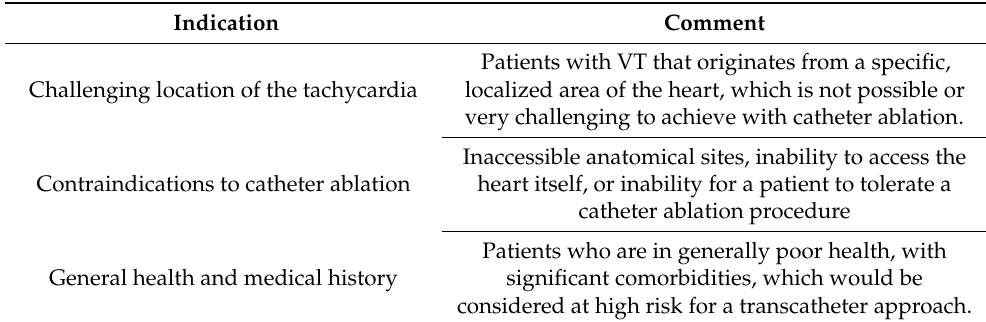
Table 1. General patient selection criteria for STAR. VT (ventricular tachycardia), CT (cardiac tomog- raphy), MRI (magnetic resonance), 3D (three-dimensional). Indication Comment Patients with VT that originates from a specific, Challenging location of the tachycardia localized area of the heart, which is not possible or very challenging to achieve with catheter ablation. Contraindications to catheter ablation catheter ablation procedure General health and medical